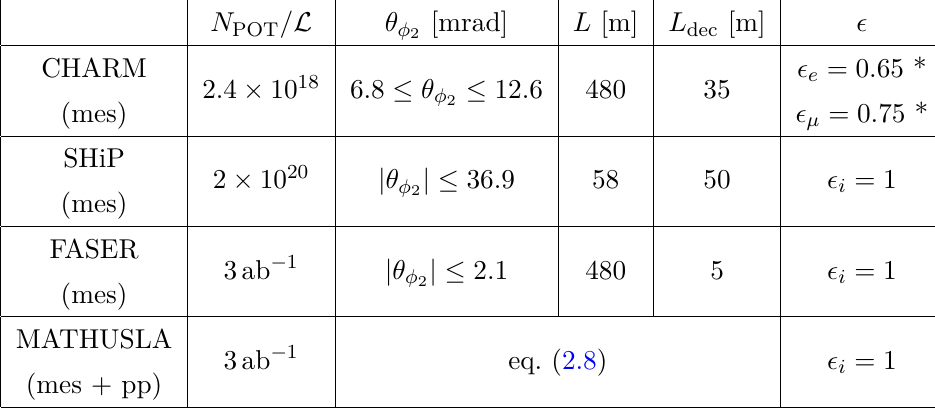
is the angle between 2